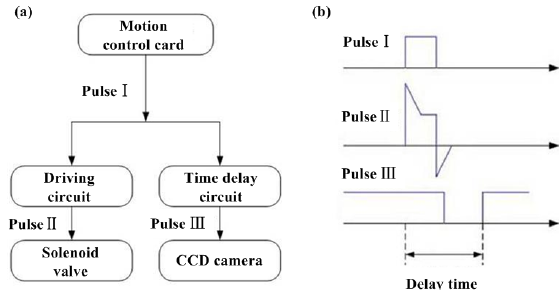
Figure 4. ( a ) Pulse signal flow chart, ( b ) pulse signal timing sequence diagram.